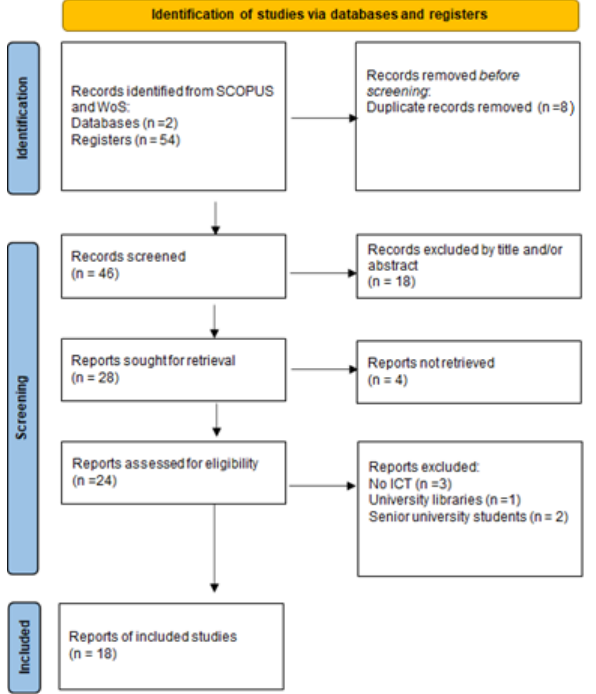
Figure 1. Study selection flow diagram (adapted from the PRISMA diagram) [54].